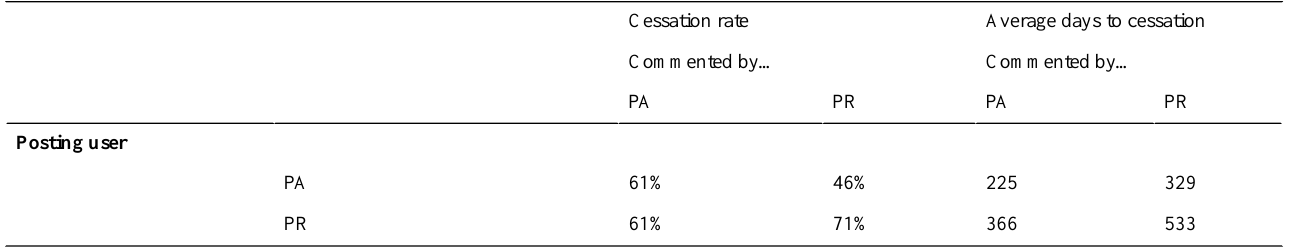
Table 1. Rates of stopping posting highly relevant photos by pro-anorexia (PA) and pro-recovery (PR) users.